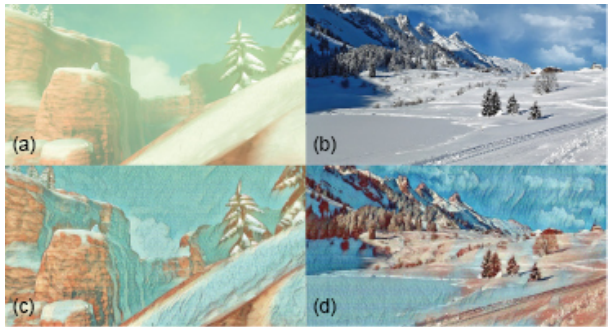
Figure 1. Two images used in the survey. Panels (a) and (b) are original and (c) and (d) are processed through the “van Gogh” fil- ter. The left two images are from the video game The Legend of Zelda: Breath of the Wild and the right two images are from the real world. The bottom two figures were presented in the survey with the question “Knowing that this picture has gone through a “van Gogh”-filter, how likely do you think it is that the features depicted in the artistic renderings could exist in the real world?”. We used a 10-point scale where 1 = completely unlikely to 10 = completely likely. High-resolution versions of images (originals and after filters were applied) are available in the